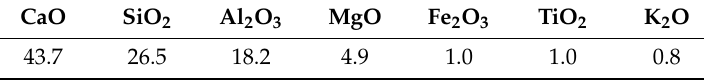
Figure 1. Particle sizes distribution of GBFS. Table 1. The main chemical element composition of GBFS (wt. / %).